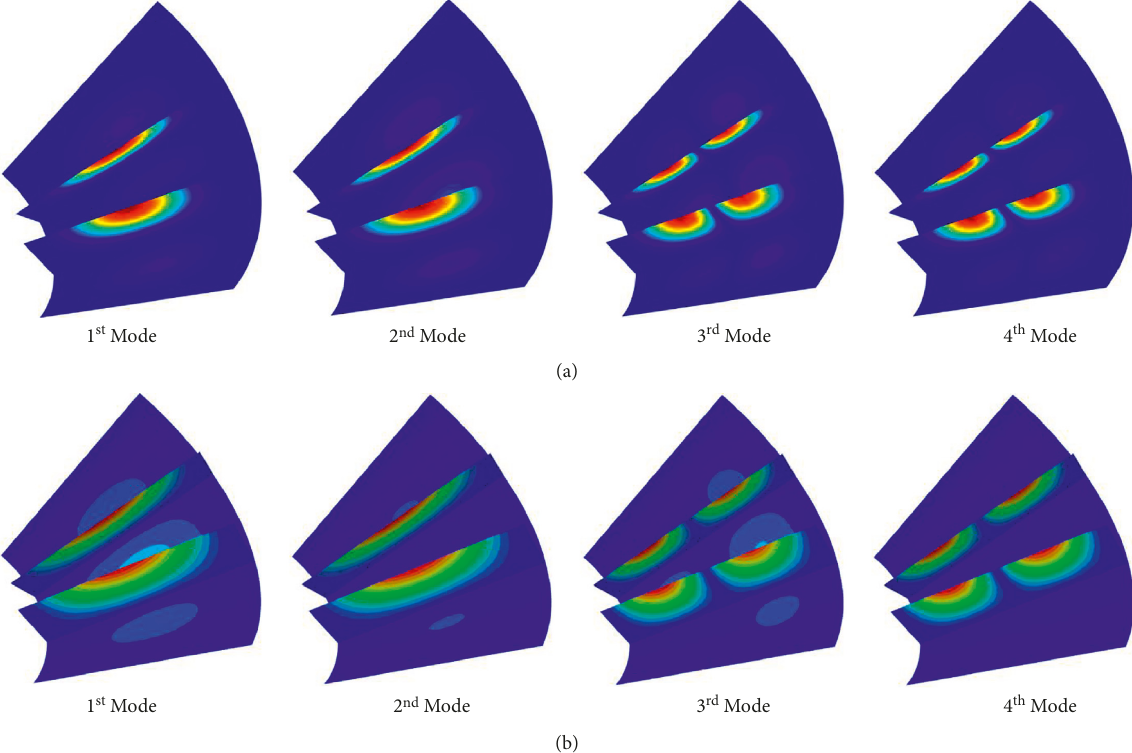
Figure 6: Mode shapes of functionally graded open conical shells with two axial bulkheads and CCCC boundary conditions ( α � 30 ° ): (a) present and (b)